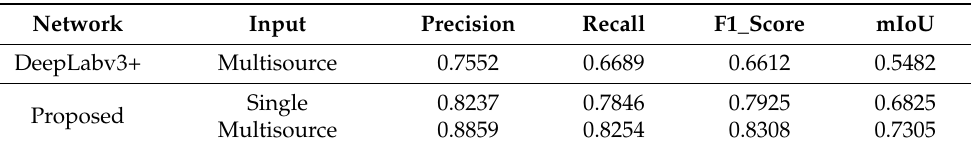
Table 2. Quantitative evaluation with the ground-truth data.